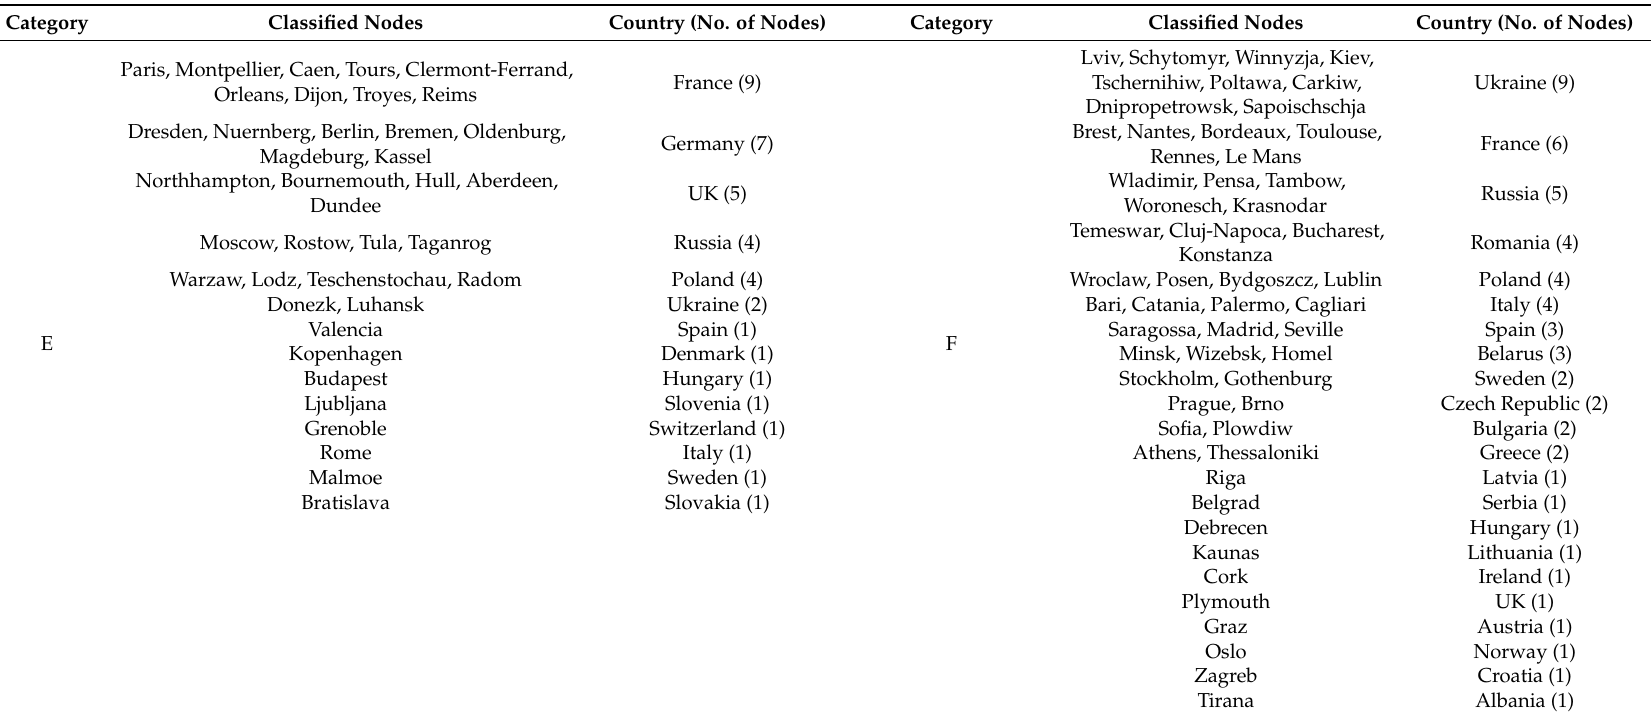
Table 2. Detailed list of classified nodes, which are not part of any territorial region beyond the metropolitane area and hinterland (Category E–F); arranged by quantity of nodes per